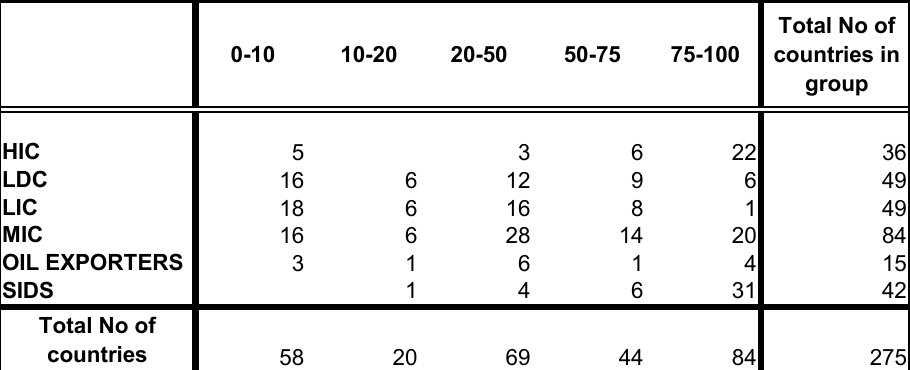
Table 1. Cereal import dependence 2007-9 (number of countries with percentage share of imports to total domestic supply in given range).